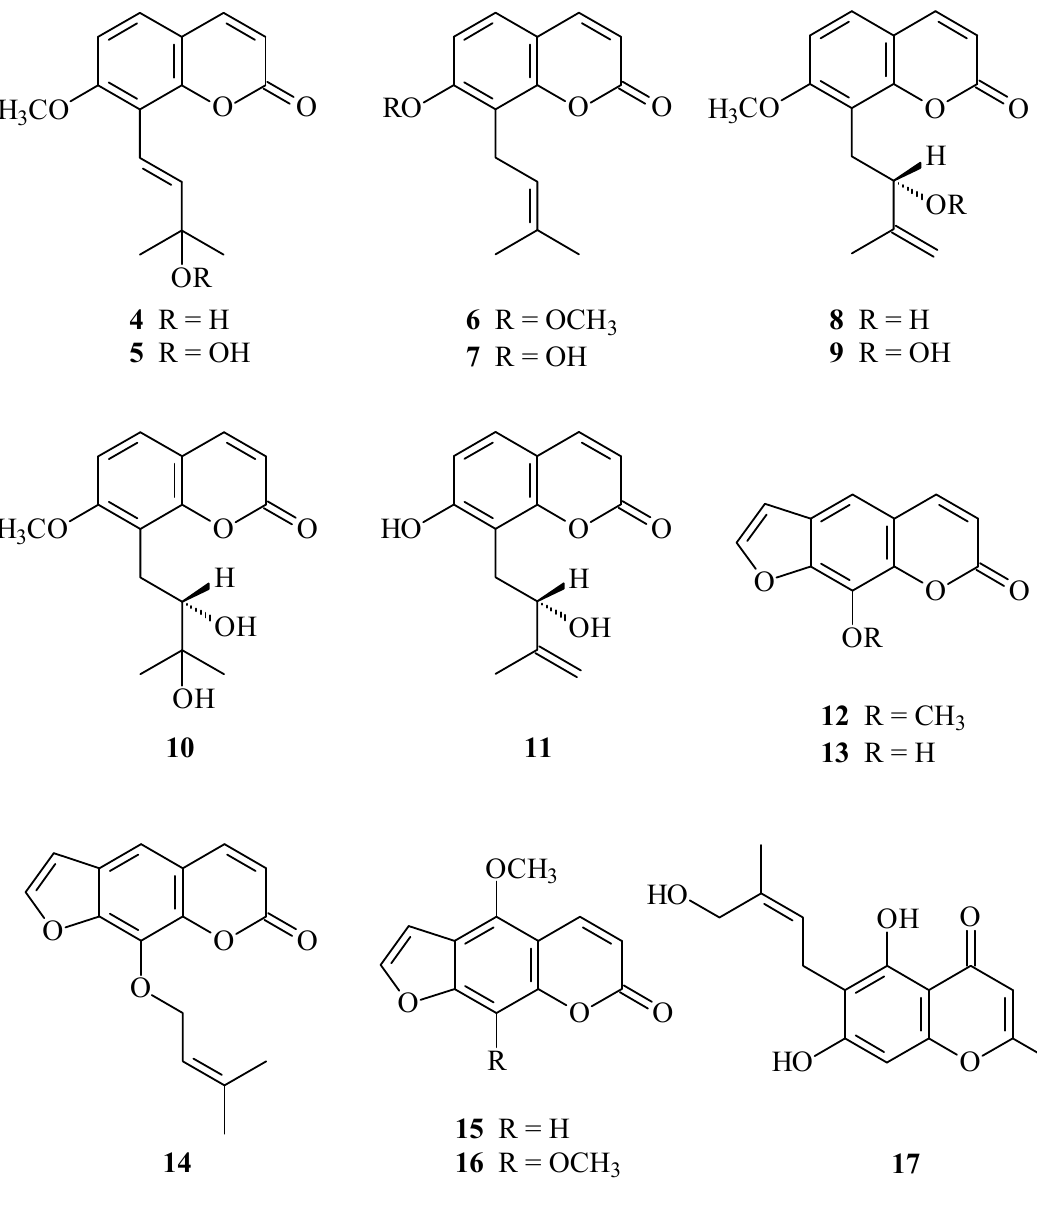
Figure 2. The chemical structures of known compounds 4 – 17 isolated from C. monnieri